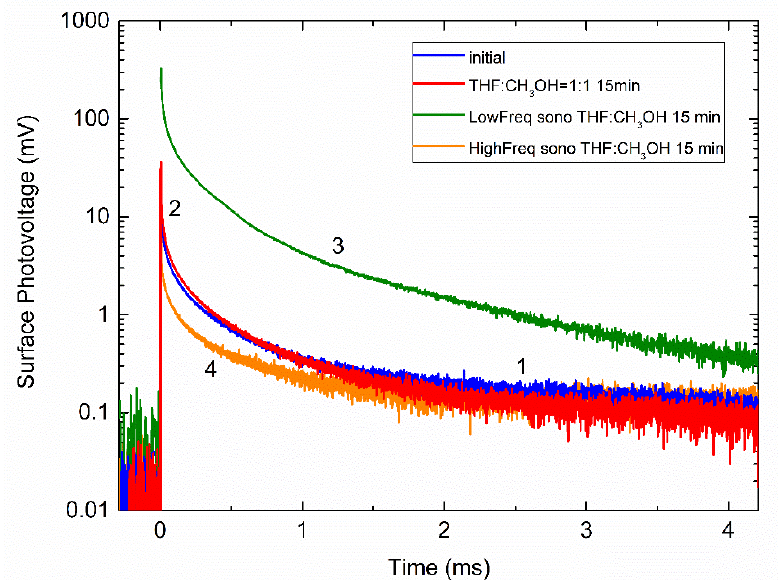
Figure 8. Time-dependent SPV of Si samples before (curve 1) and after chemical (curve 2) and sonochemical treatments at about 28 (curve 3) and 400 kHz (curve 4) in tetrahydrofuran/methanol mixture with a volume ratio of 1/1.